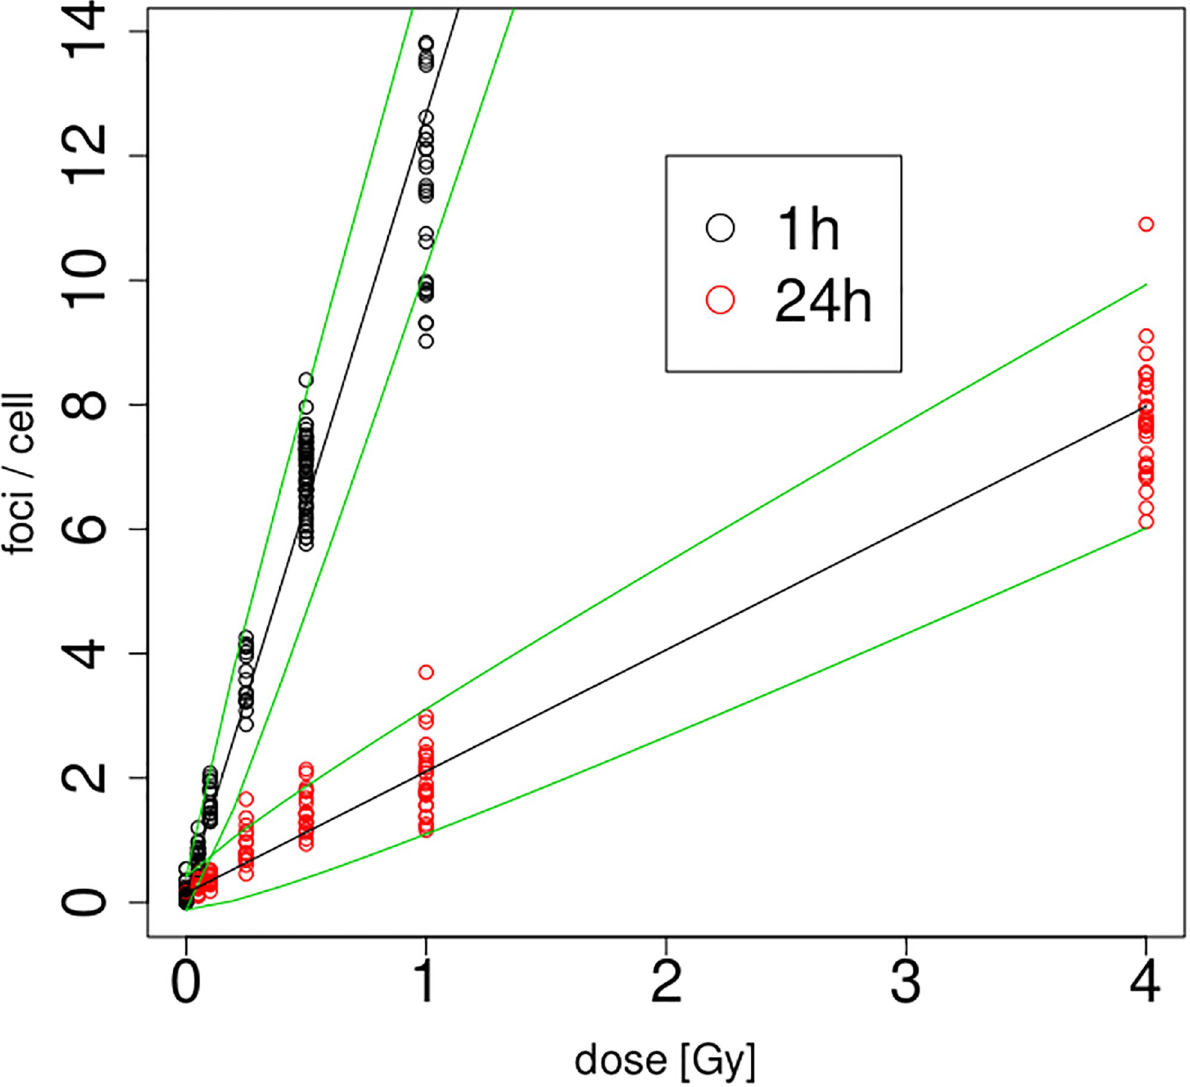
Fig 5. Linear calibration curves with approximate 95% prediction